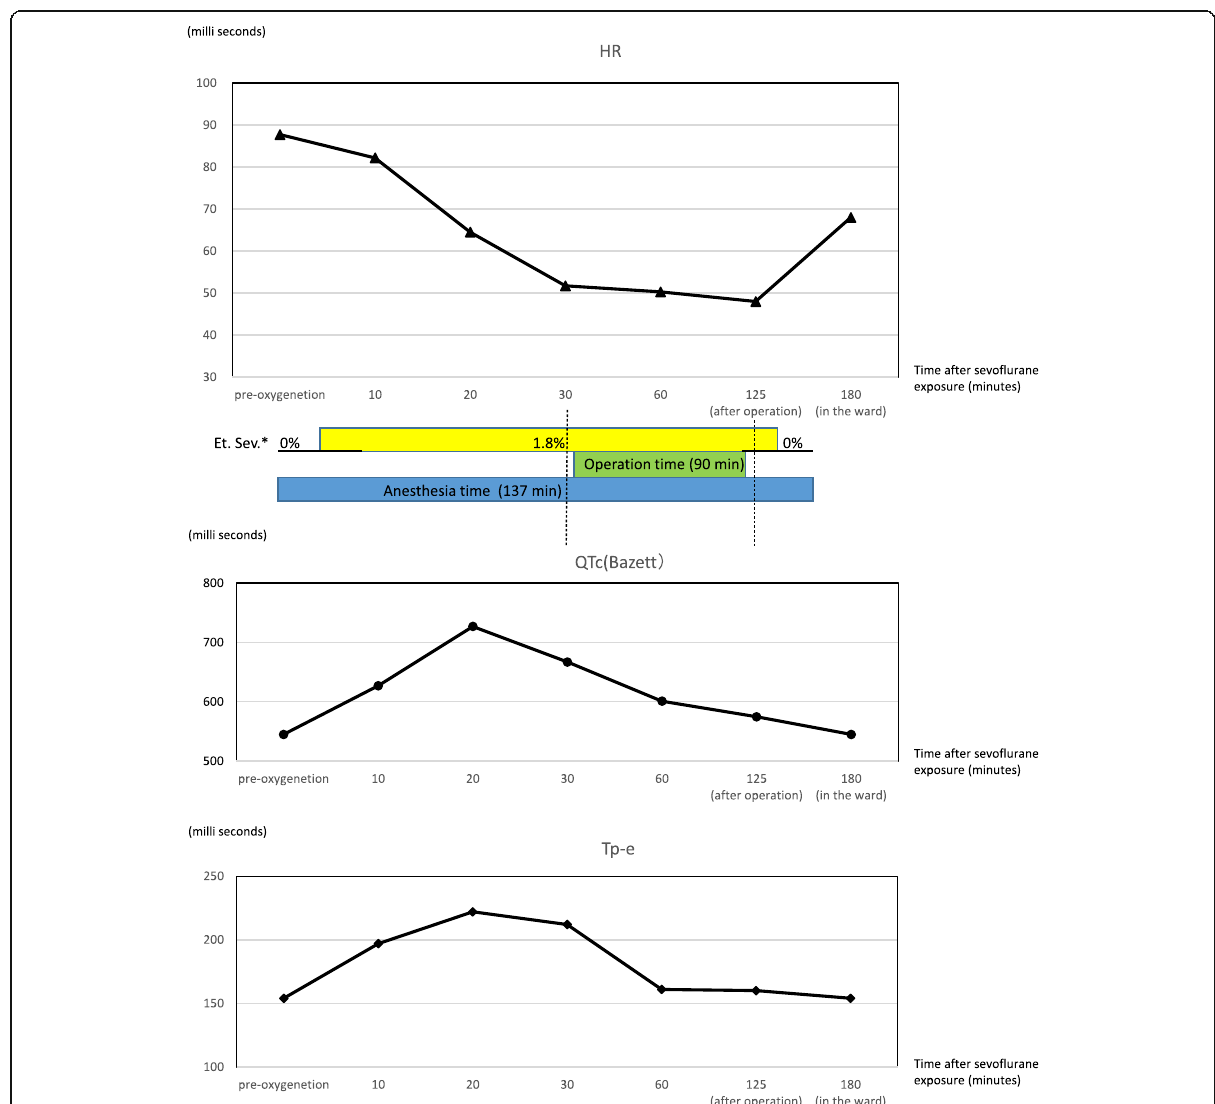
Fig. 2 Time courses of the QTc interval, the Tp-e interval, and the HR interval during anesthesia. The QTc interval, the Tp-e interval was also prolonged after sevoflurane exposure, with peaks of QTc (727 ms) and Tp-e (222 ms) at 20 min after sevoflurane exposure. Both the QTc and the Tp-e intervals gradually decreased with time and returned to around the pre-anesthetic levels 40 min after sevoflurane